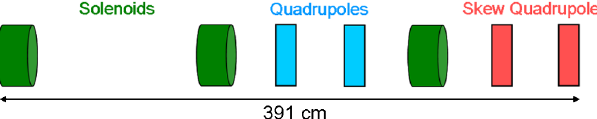
FIG. 3. Beam line from left to right for emittance transfer of a beam extracted from an ECR source (here the GSI HLI source). It comprises three solenoids, two quadrupoles, and two skew quadrupoles. Apertures are not to